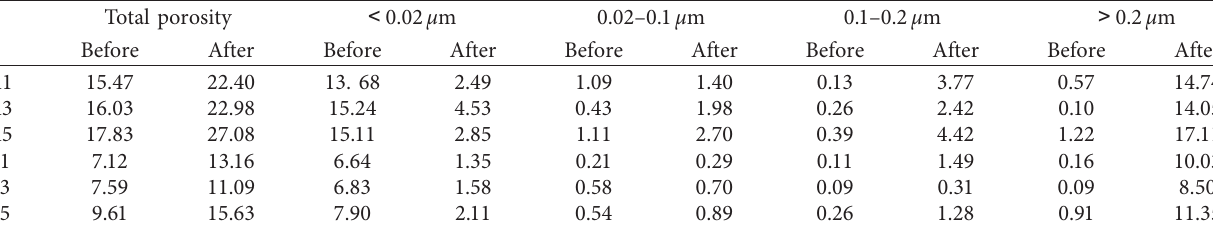
Table 11: Porosity of concrete